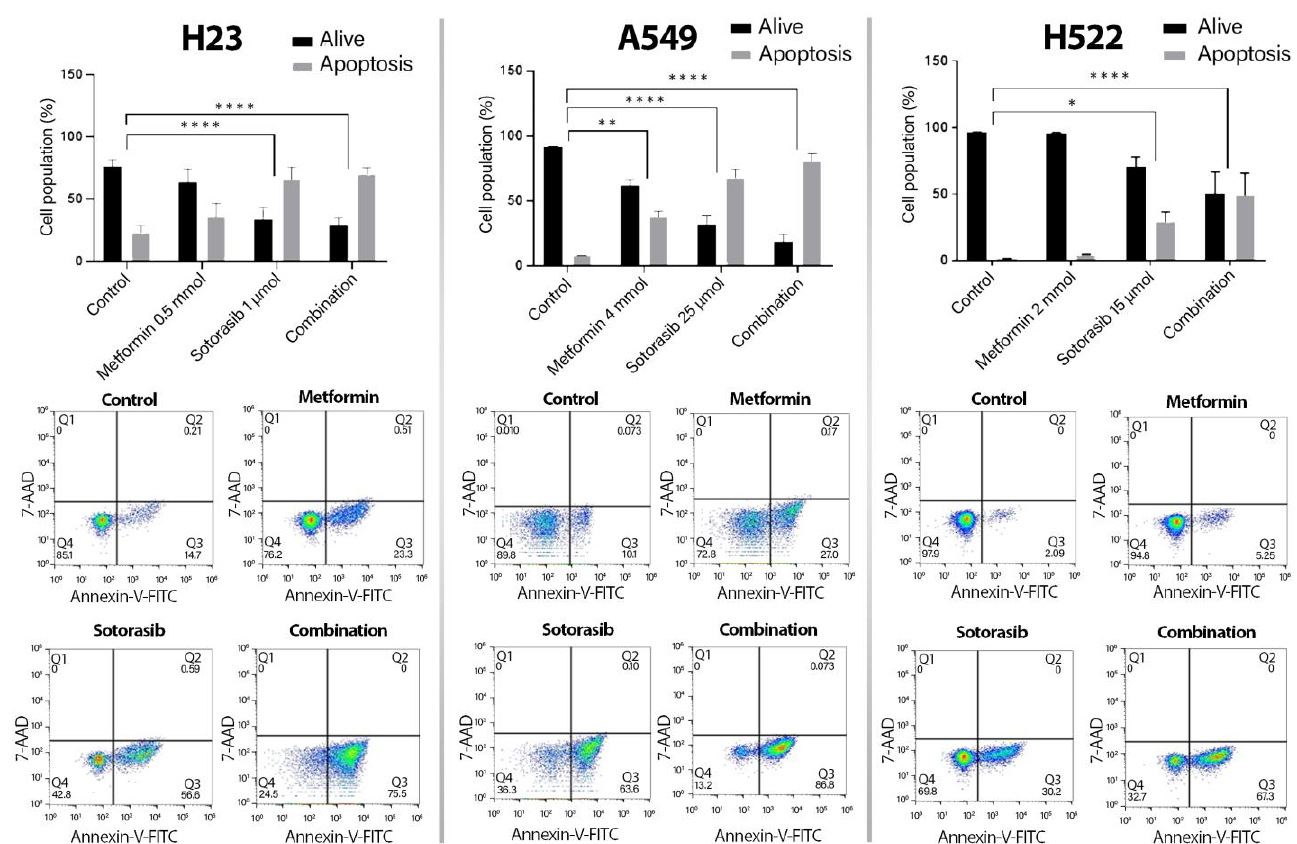
Figure 2. Induction of apoptosis by sotorasib and metformin as monotherapies or in combination. Cells were seeded and treated as previously described for 72 h. 5000 events were analyzed with the apoptosis kit and flow cytometry. Bars represent the means of 2 independent experiments in triplicate. Two-way ANOVA was carried out to perform the statistical analysis * p ≤ 0.05, ** p ≤ 0.01, **** p ≤ 0.0001. Q1, necrosis. Q2, late apoptosis. Q3, early apoptosis. Q4, living cells.